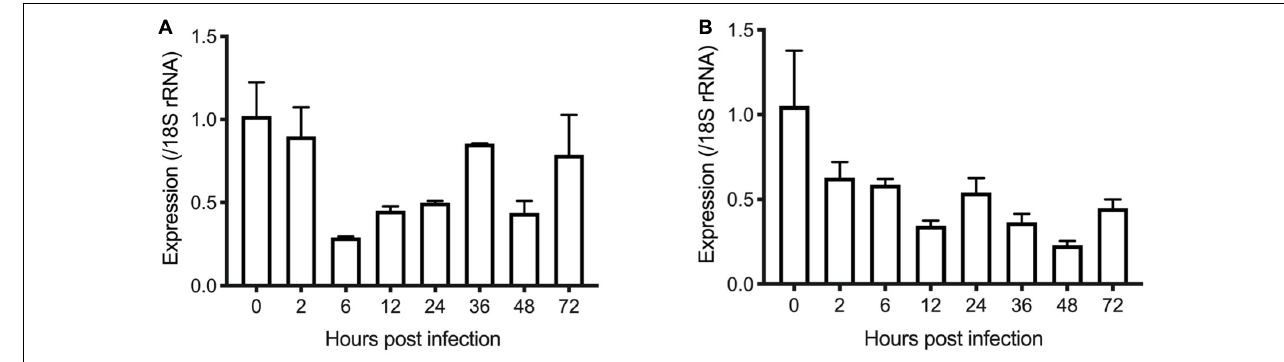
FIGURE 4 | Transcription levels of the INS-21 (A) and INS-23 genes (B) in developmental stages of C. parvum . The relative expression of the INS gene at various C. parvum cultivation time was determined by reverse transcription-qPCR, with data being normalized with data from the expression of the Cp 18S rRNA gene.